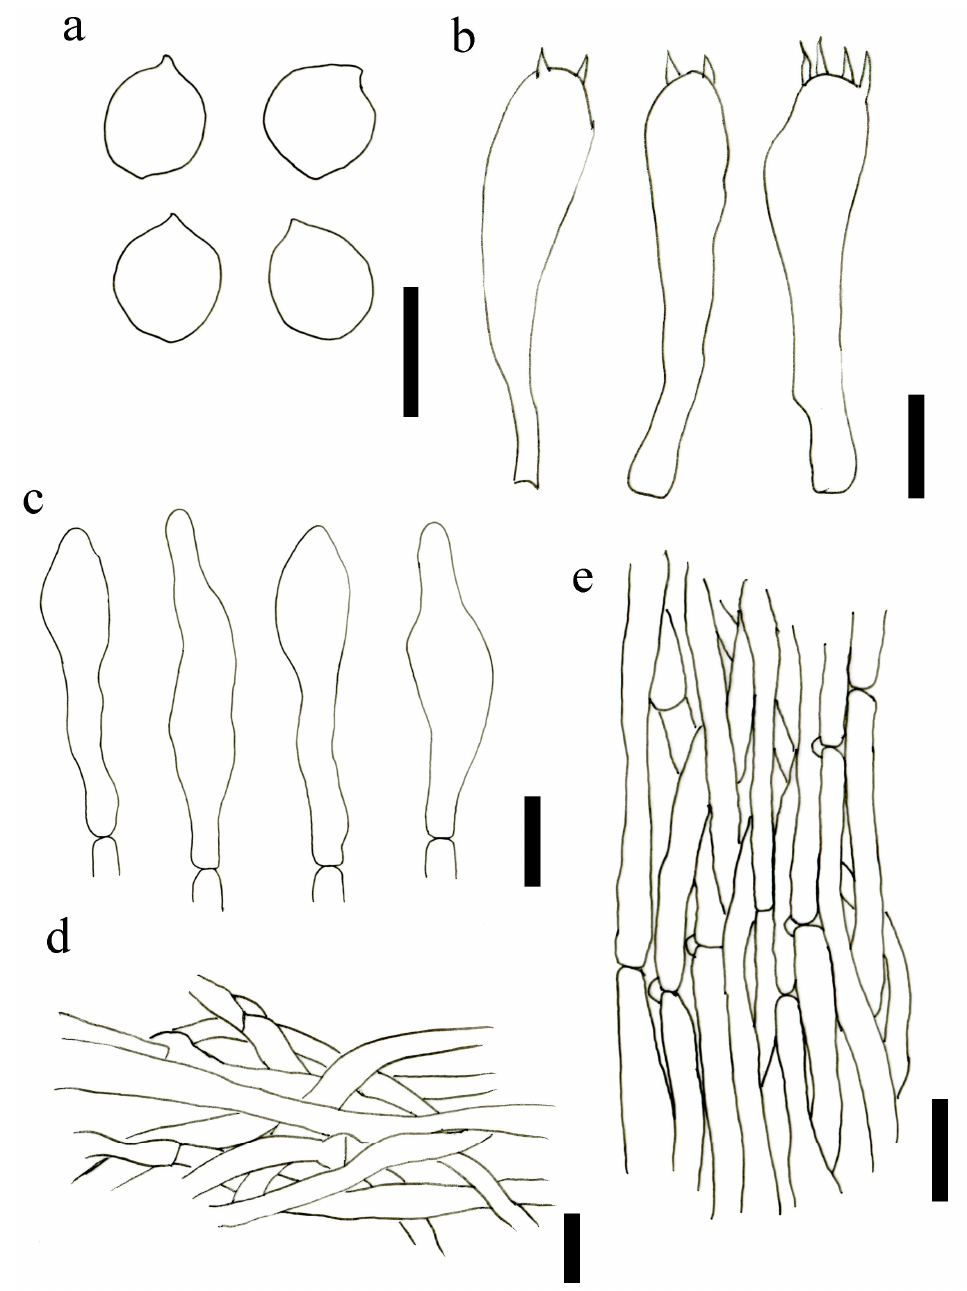
Figure 6. Microscopic features of L. subdecastes (HMJAU63468). ( a ) Basidiospores; ( b ) Basidia; ( c ) Pleurocystidia; ( d ) Pileipellis; ( e ) Stipitipellis. Scale bars: ( a ) = 5 μ m; ( b – e ) = 10 μ